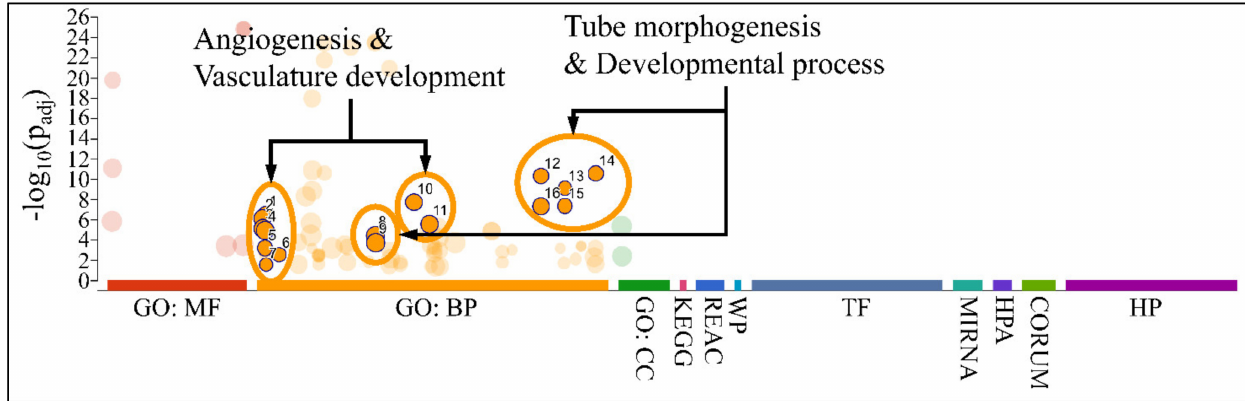
Figure 12. Gene ontology annotation of DE miRNAs. Major functions revealed, included angiogenesis, vasculature development, and developmental processes, such as tube morphogenesis and development (Legend: MF: Molecular function; BP: Biological process; CC: Cellular component; KEGG: KEGG pathway database; REAC: Reactome pathway database; WP: WikiPathways; TF: Transcription factor binding motifs; MIRNA: miRNA targets; HPA: The human protein atlas; CORUM: The comprehensive resource of mammalian protein complexes; HP: Human phenotype